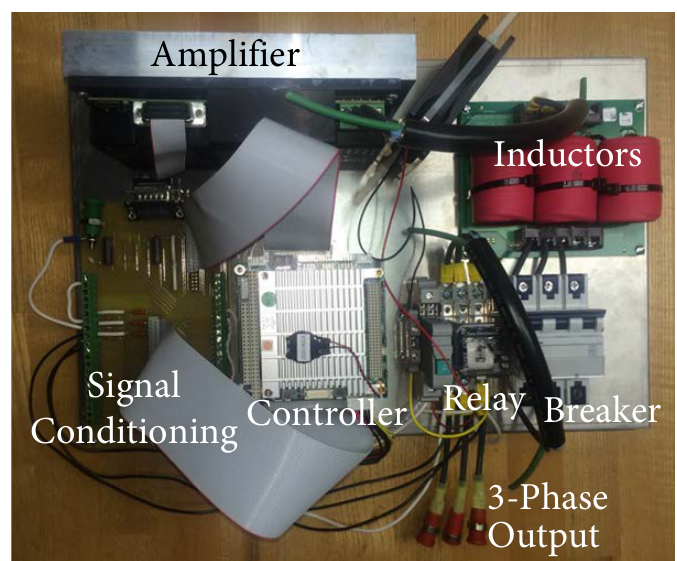
Figure 7. One power converter subunit, as shown schematically in Figure 6. The testbed comprises three subunits connected in parallel to a Y-connected three-phase load. A DC source (not shown) feeds power to the inverter in the top left of the